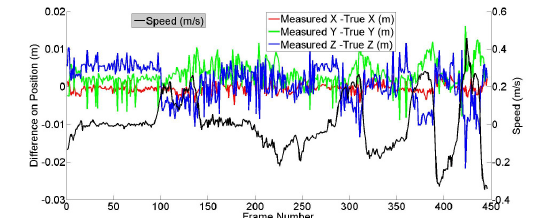
Figure 7: Evaluation of the tracking process while varying the speed of the hand movement in the range direction.